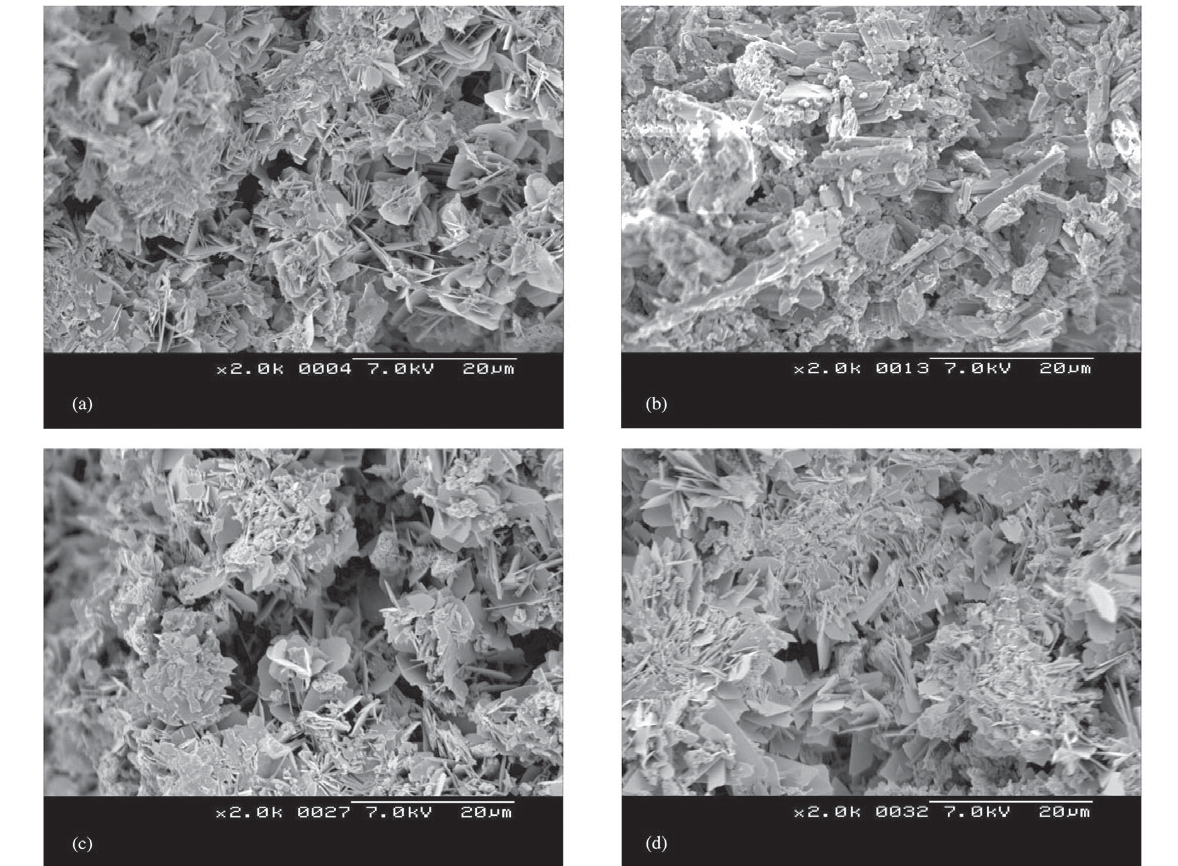
Figure 7. SEM micrographs of the fracture surface of cement after 48 and 112 h of hydrolysis in different parts of the sample: (a) 48 h, near to the outer surface; (b) 48 h, at the centre; (c) 112 h, near to the outer surface; (d) 112 h, at the centre. (Cement: fine β -TCP; L/P = 1.0 ml/g; 1.0 M Na HPO 2 4